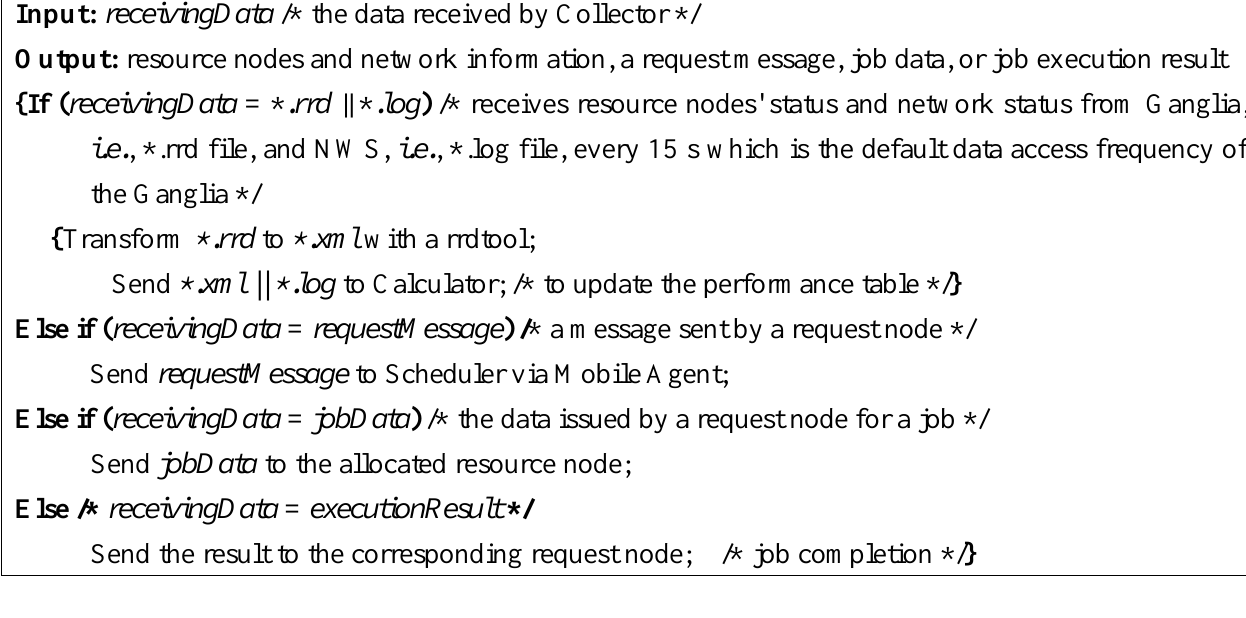
Figure 4. The algorithm performed by Collector on receiving a message or data from other components.